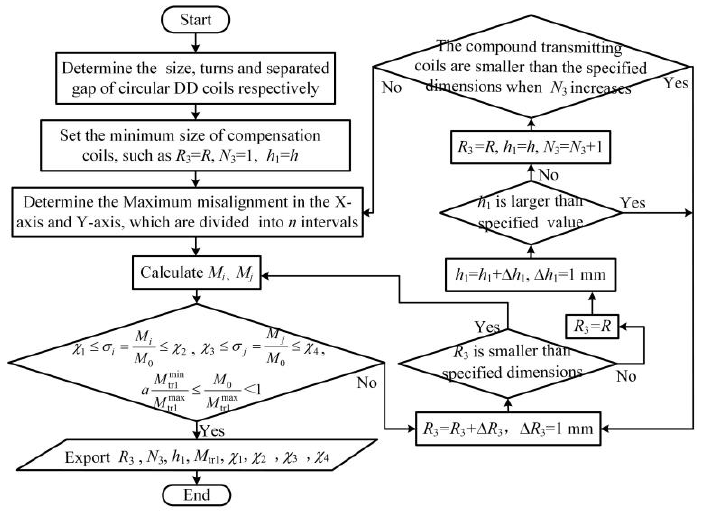
Figure 6. Flowchart of parameters optimization of compensation coils.